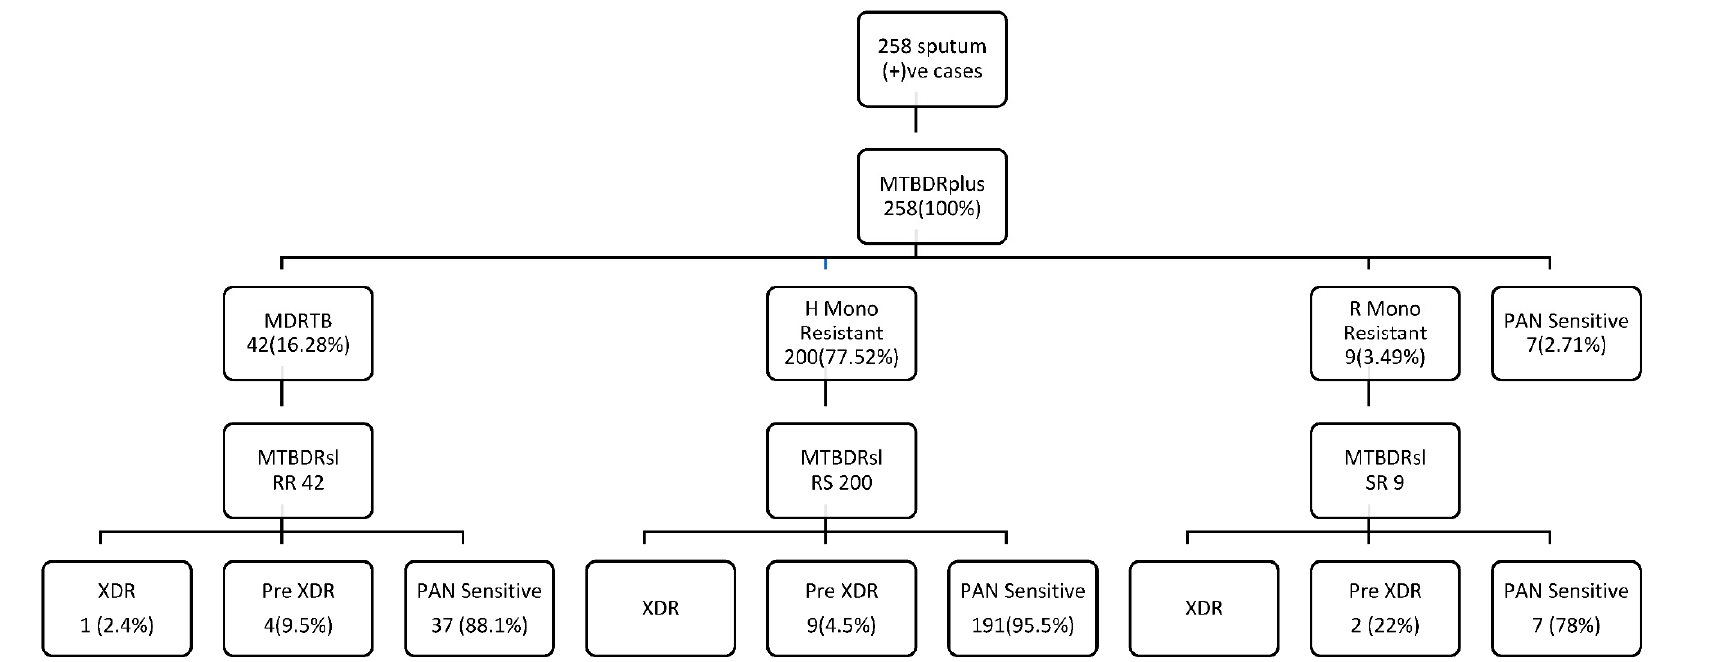
Figure 1. Flow diagram of drug case enrollment for MTBDRsl assay.